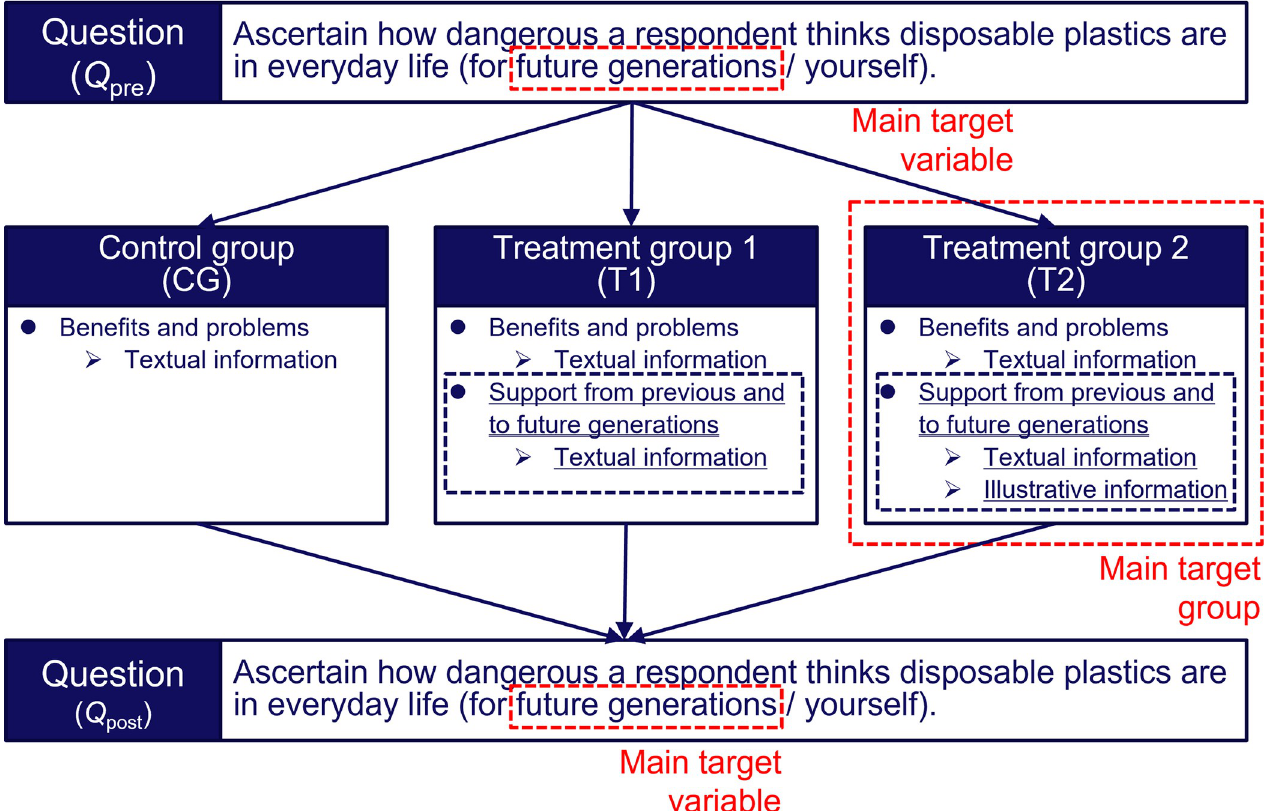
Fig 2. Experimental procedure for investigating nudging messages for recycling disposable plastics. The black dashed boxes show the interventions. The targets of the interventions are highlighted with red dashed boxes.